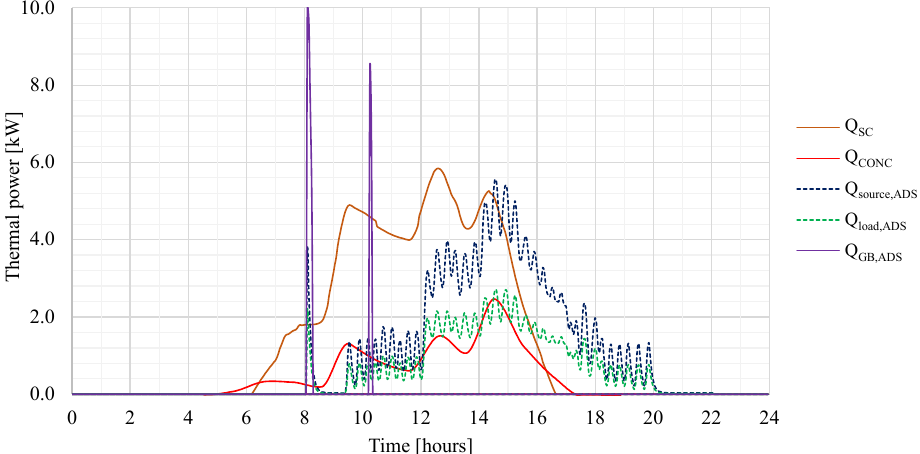
Figure 8. Thermal powers of the main system components, summer day.